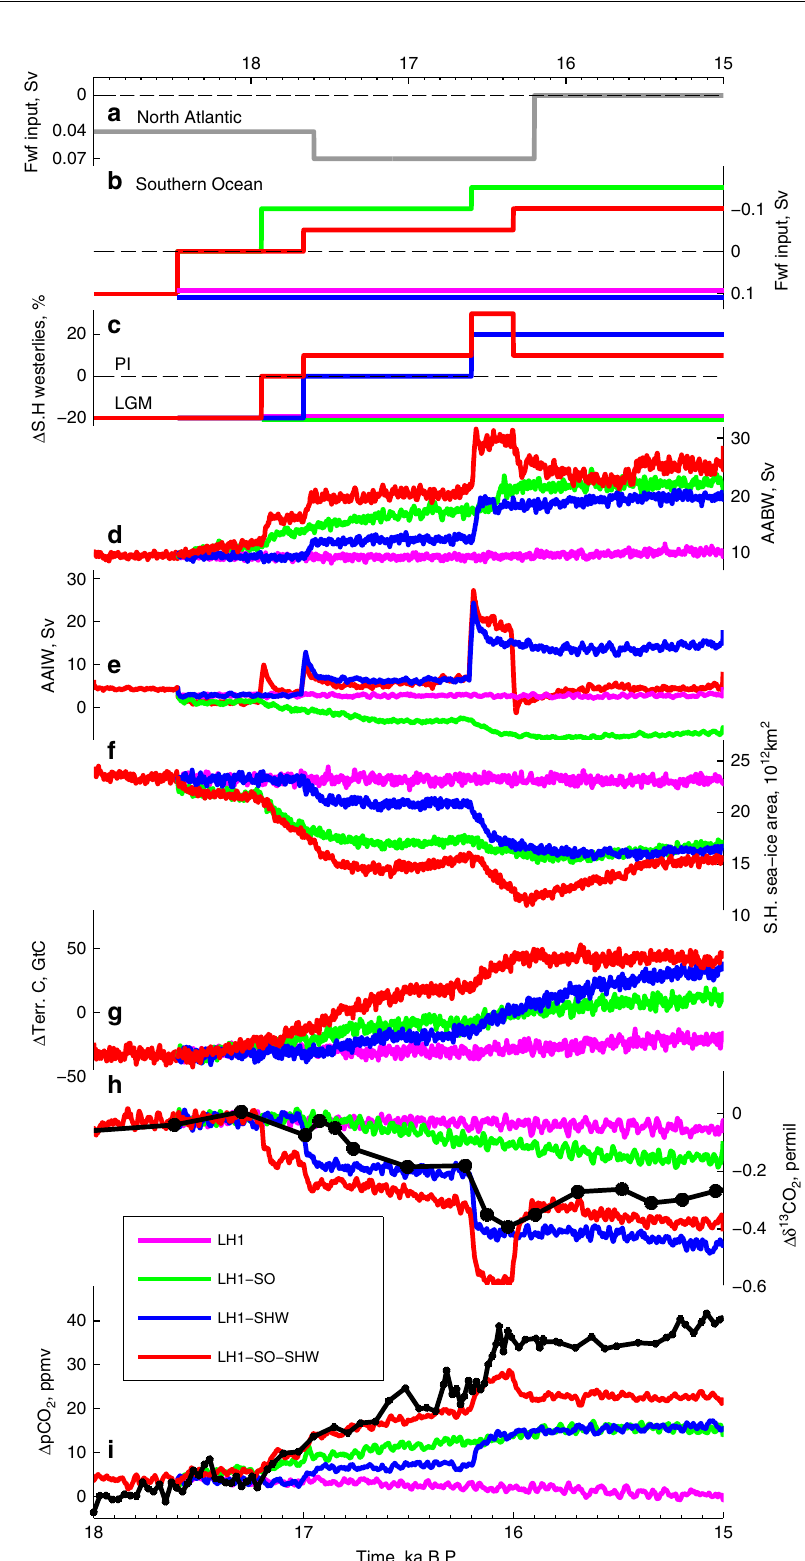
Fig. 3 Summary of transient experiments. Timeseries of freshwater input into a the North Atlantic and b the Southern Ocean and c SH westerly wind forcing. Simulated d AABW; e AAIW; f SH sea-ice area; g terrestrial carbon reservoir anomalies with respect to 19 ka (Supplementary Table 1); h Δ δ 13 CO 2 and i Δ p CO 2 ; for all transient experiments (colour). 5 – 21 years moving average are shown for all the variables except for the terrestrial carbon to fi lter the high-frequency variability. WDC p CO 2 7 and Taylor Glacier δ 13 CO 2 19 are shown in